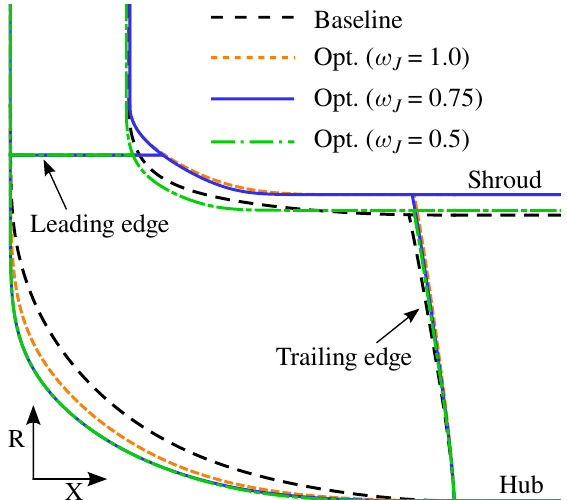
Figure 6. Comparison of the optimized meridional contours using different weights ω J in the weighted objective function.